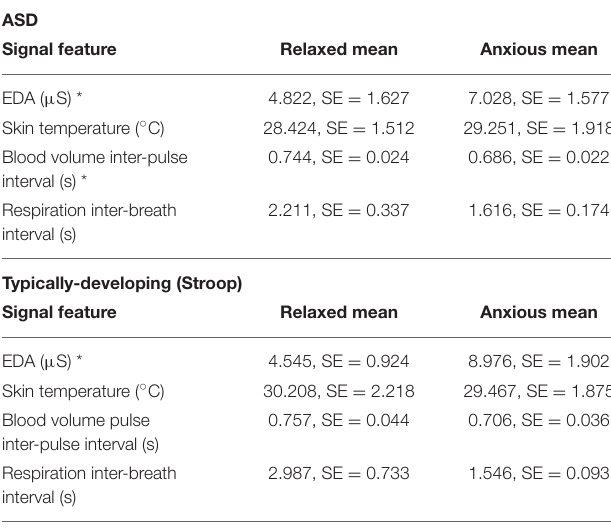
TABLE 4 | Means and standard error of physiological features recorded in Experiment 2 from children with ASD ( n = 5) and typically developing children ( n = 5) during the relaxed state condition and the anxiety-provoking